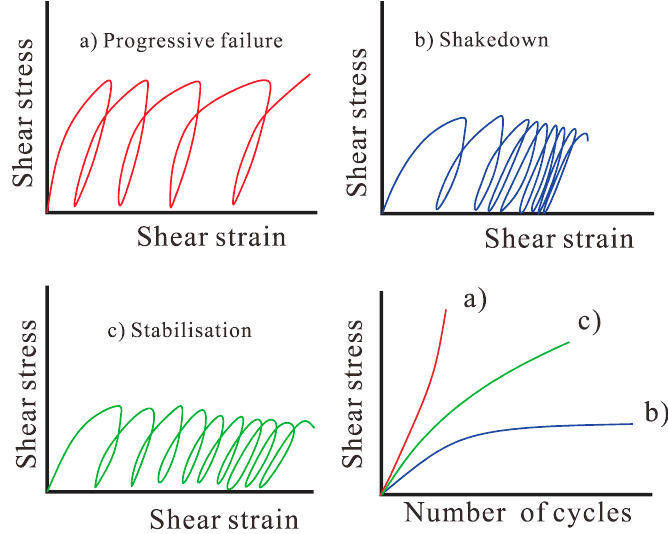
Figure 8. Failure modes of granular soils due to cyclic loading. Modified from Shajarati et al. (2012) [46].